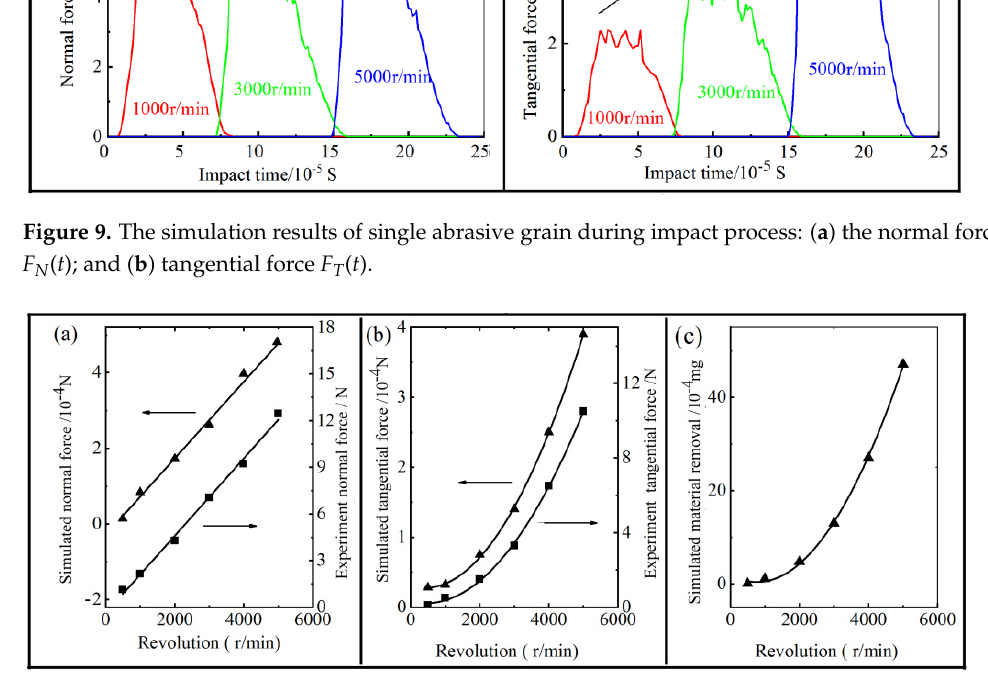
Figure 10. The effect of revolution speed on the normal force ( a ); tangential force ( b ); and the mass of material removal ( c ).